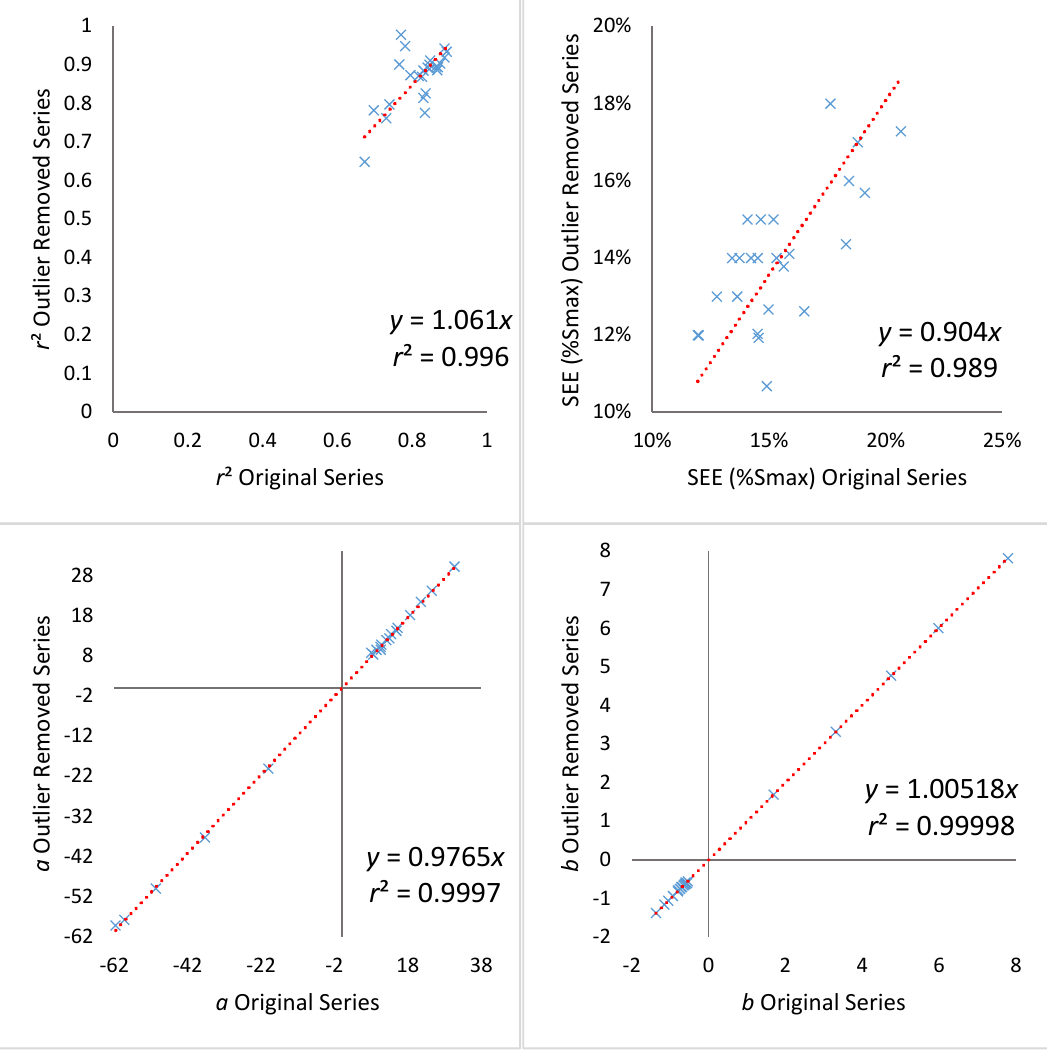
Figure 11. Linear fit and determination coefficient of the model performance indicators ( r 2 and SEE, %Smax) and the regression parameters ( a and b ) obtained with all models and soil water storage capacities using the original data series and the outlier-removed data series.